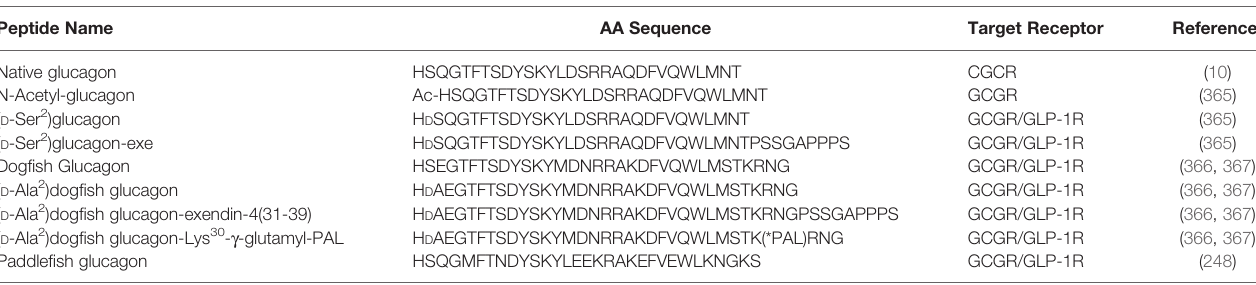
TABLE 7 | Glucagon and related peptide analogues at preclinical stage for T2DM.